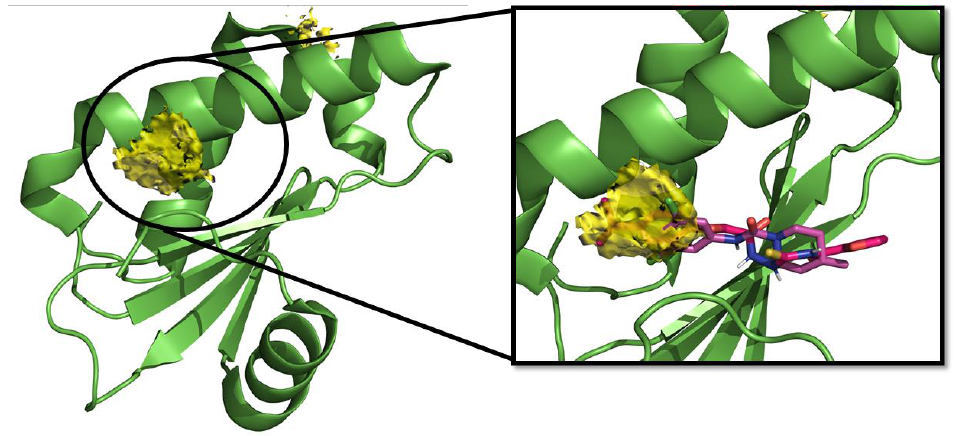
Figure 3. Hotspot maps calculated for the protein. Overlay between the hotspot maps and the predicted binding mode for RNPA2000 and JC1 in the hypothesized binding site.